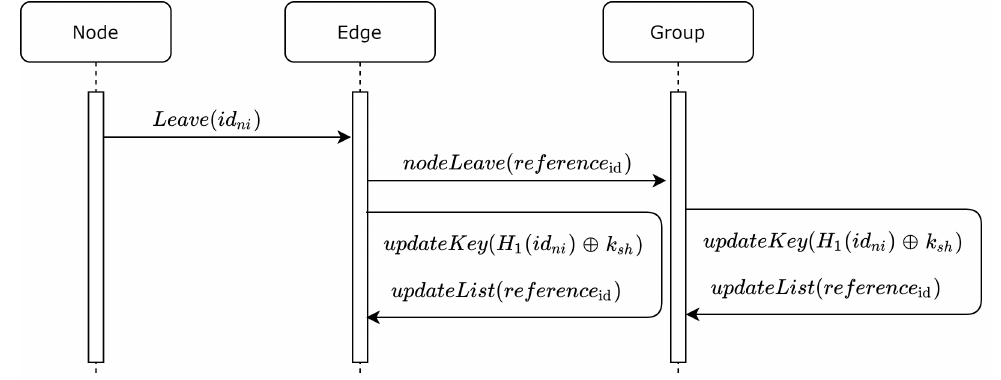
Figure 4. Sequence diagram for node leaving the